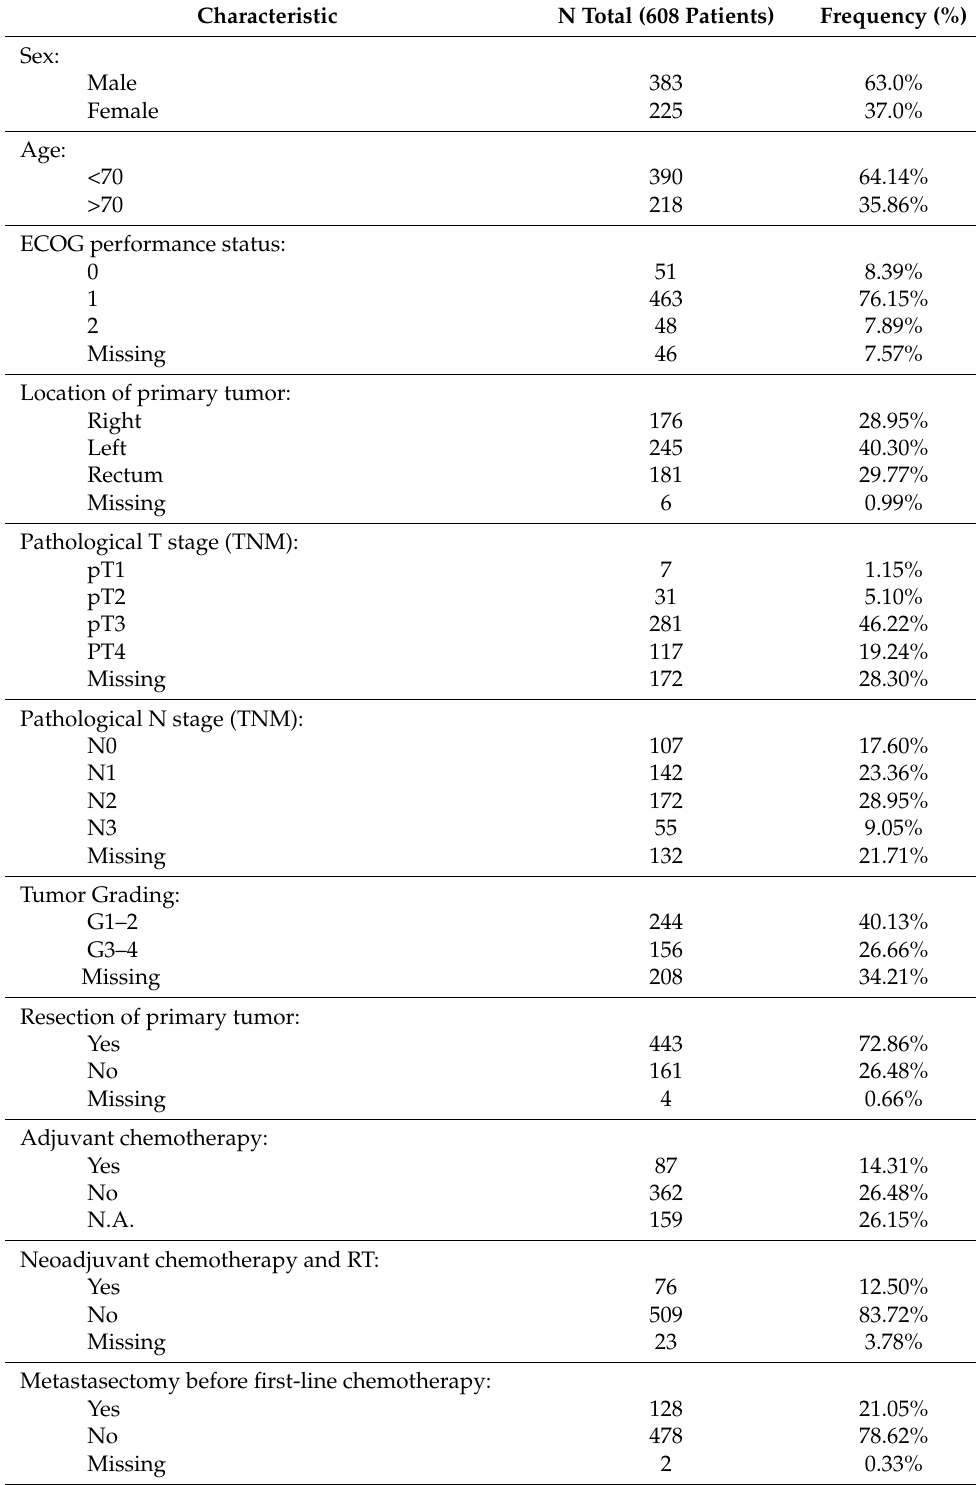
Table 1. Demographic and clinical characteristics of the patients at baseline. Frequencies of variables are reported by absolute number and by percentage